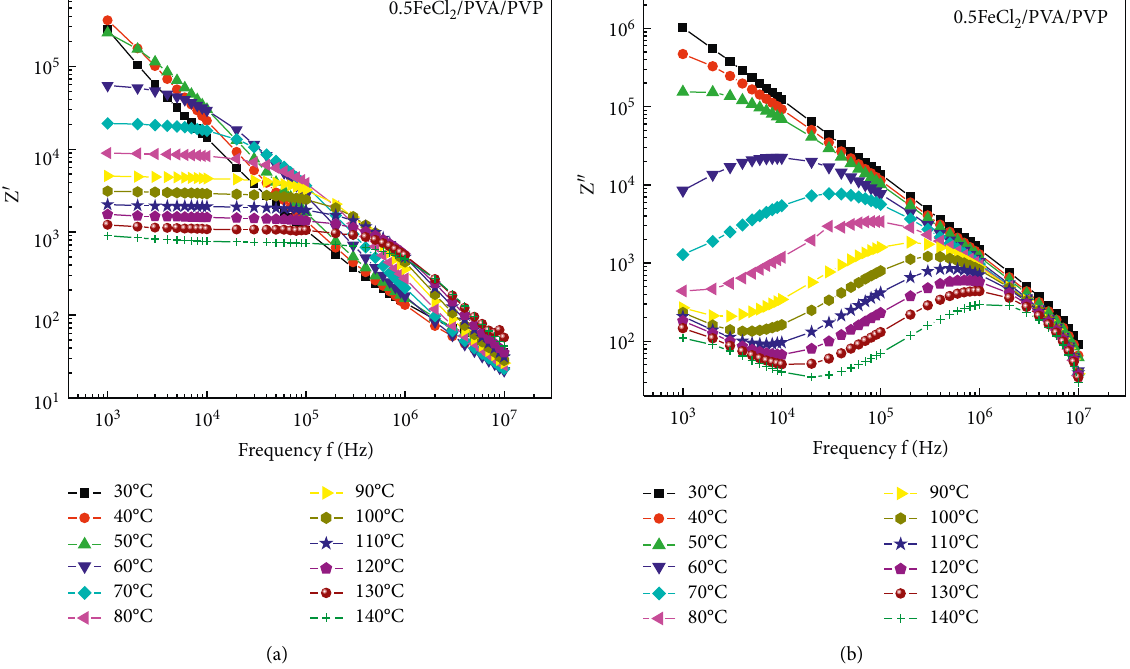
Figure 3: (a) Real part of impedance (Z ′ ) and (b) imaginary part of impedance (Z ′ ) for 0.5wt.% FeCl